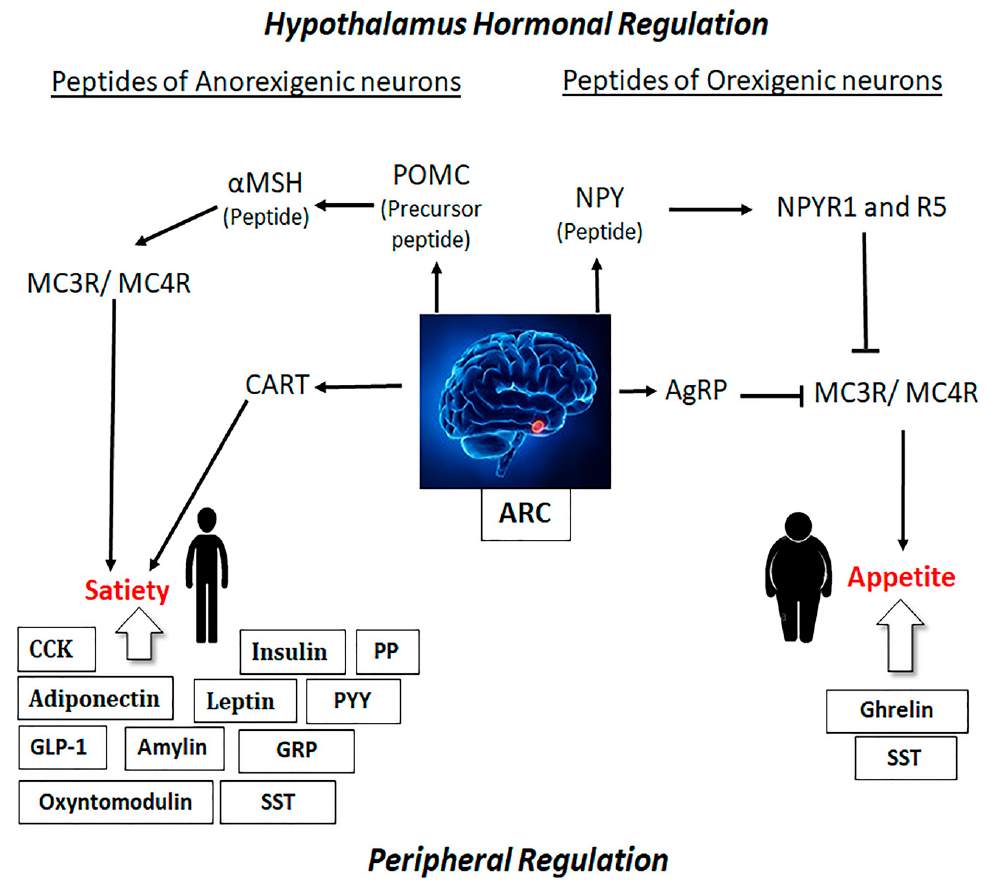
Figure 1. Overview of orexigenic and anorexigenic stimuli in association with peripheral hormones in regulation of appetite and satiety. ARC is composed of orexigenic neurons producing NPY and AgRP and anorexigenic neurons, which synthesize POMC and CART. The peripheral hormones regulate appetite via endogenous gut hormones such as CCK, GLP-1, oxyntomodulin, PYY, and PP, producing an anorexigenic e ff ect. Ghrelin and SST have an orexigenic e ff ect in humans and prompt food intake. In addition, SST produces dual e ff ect (orexigenic and anorexigenic). Pointed arrows indicate activation; Blocked arrows indicate inhibition. ARC, arcuate nucleus; AgRP, agouti related peptide; CART, cocaine and amphetamine-regulated transcript; CCK, cholecystokinin; GLP-1, glucagon like peptide-1; GRP, gastrin-releasing peptide; NPY, neuropeptide Y; POMC, propiomelanocortin; PYY, peptide YY; NPY, neuropeptide Y; PP, pancreatic polypeptide; α MSH, α -melanocyte stimulating hormone; MCR, melanin-concentrating hormone receptor; SST, somatostatin. In addition to POMC, the presence of leptin receptors in the hypothalamus contributes significantly to the regulation of food intake and energy balance. The perturbed leptin signaling is often seen in obese person and ob/ob and db/db mouse model devoid of leptin and leptin receptor gene [85,86]. It is interesting to note that leptin is not restricted to the hypothalamus, but also present in the hippocampus, which principally is involved in learning and memory, and similarly contains leptin receptor and associated with energy regulation [87,88]. The authors further demonstrated increased body weight and food intake in rats with lesion of hippocampus. Furthermore, developing diet-induced obesity often resulted from the failure of leptin mediated signaling in POMC and AgRP neurons in ARC. Previous studies have shown that the absence or inhibition of AgRP neurons in ARC leads to suppressed the food intake, whereas activation prompts food-seeking behaviour even in